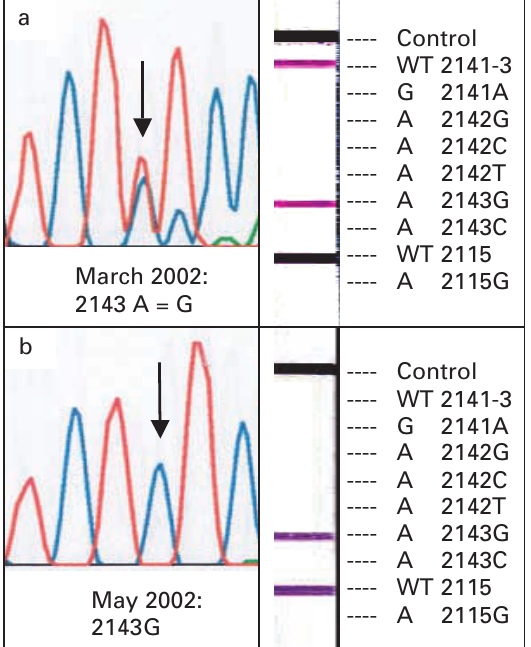
Patient MR with eradication failure between consecutive biopsies in year 2000 and 2002. a) Restriction digest with Mbo2 (M, A2142G) and Bsa1 (B, A2143), U undigested frag- ment, C undigested WT control, L 100 bp ladder fragment, very left Cla R strain V15–37400 (A2143G). b) SSCP analysis: Left, single band (asterisk) for the WT strain V15–37469 and a control patient (PC). Middle, shifted band towards the bot- tom pole with widely spaced minor band above (asterisks) for the patient MR and a positive control patient (PC). Right narrowly spaced double bands (asterisks) for patient BB presented in Fig. 2 and the strain V15–4434 (both A2143G). c) Sequencing analysis.